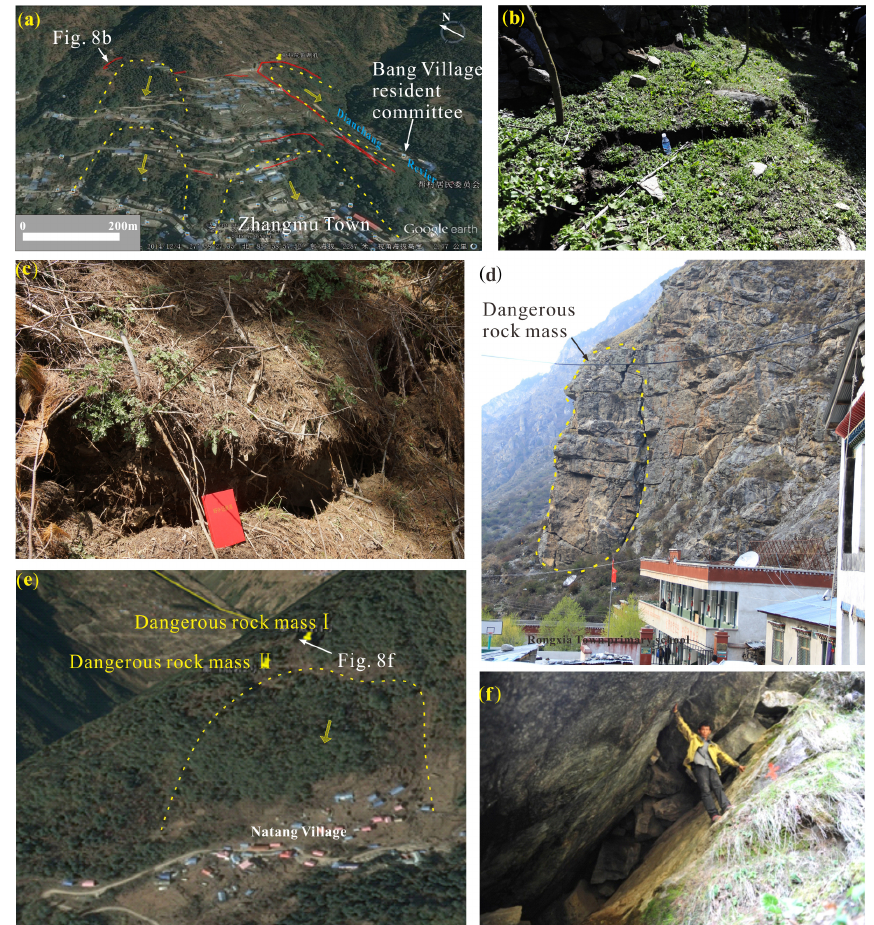
Figure 8. Fissured and unstable rock masses formed by the earthquake that indicate hazards for additional landslides and rockfalls. The yellow dotted lines show the landslide group. Arrows denote the slip direction, and the red line denotes new fissures formed during the Nepal earthquake. (a) Old landslide group at Zhangmu. (b) New fissure in the old landslide group at Zhangmu (Fig. 8a). (c) Tension fissures at the back edge of Sale Village landslide (site 7, Fig. 5b). (d) Dangerous rock mass at Rongxia Primary School (site 3, Fig. 5c). (e) Old landslide with unstable rock at Chentang Town (site 1, Fig. 5d) . (f) Fissure between unstable rock and bedrock at Chentang (Fig.